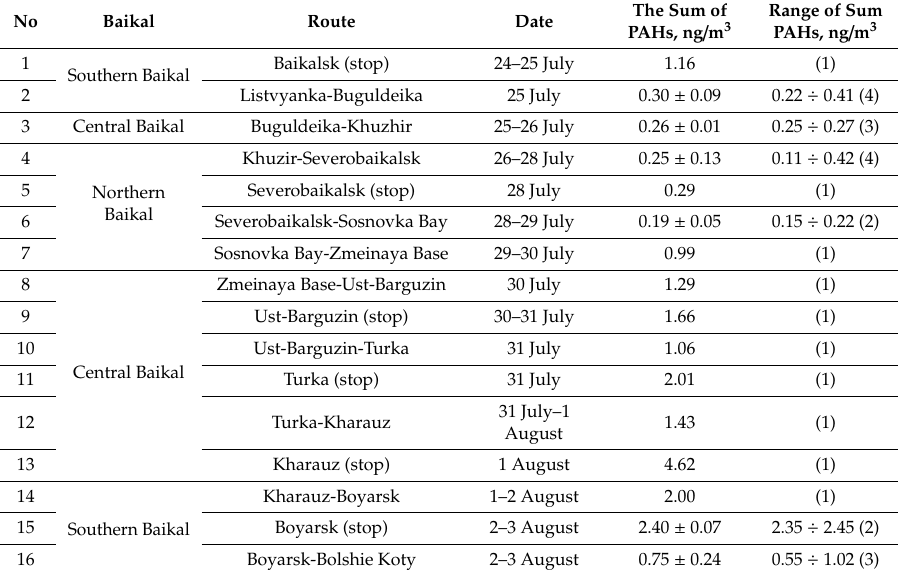
Table 5. Concentrations of PAHs in the aerosol of the near-water atmosphere above Lake Baikal along the route of the RV «Akademik V.A. Koptyug» from 24 July to 4 August 2019 (number of samples is given in